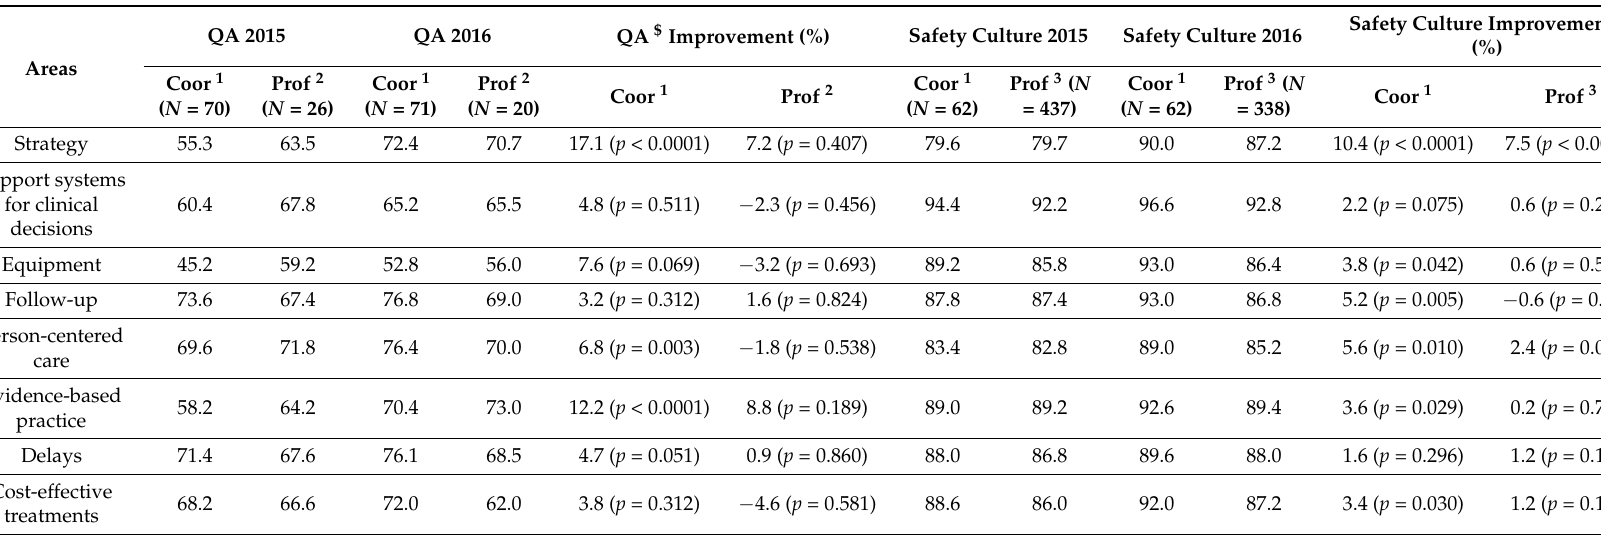
Table 3. Response trends and results comparisons of the results evaluation of the safety culture and quality assurance measurements of the quality coordinators and the rest of the